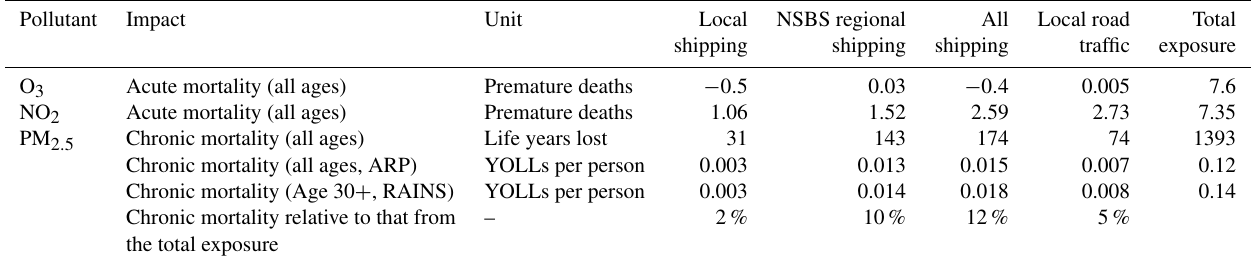
Table 3. Health impacts calculated for O 3 , NO 2 and PM 2 . 5 contributions of local and regional shipping and local road traffic to air pollution in the city of Gothenburg as well as of the total exposure to these pollutants in the city. The health impacts calculated with the ARP model and with the RAINS methodology are